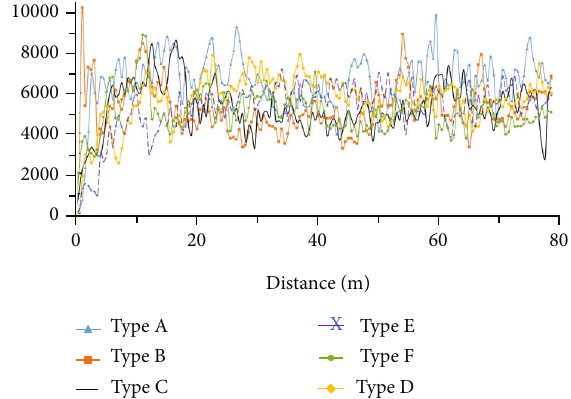
Figure 11: Variation of subsoiling resistance with distance for six subsoilers at 3km/h speed and 30cm depth.